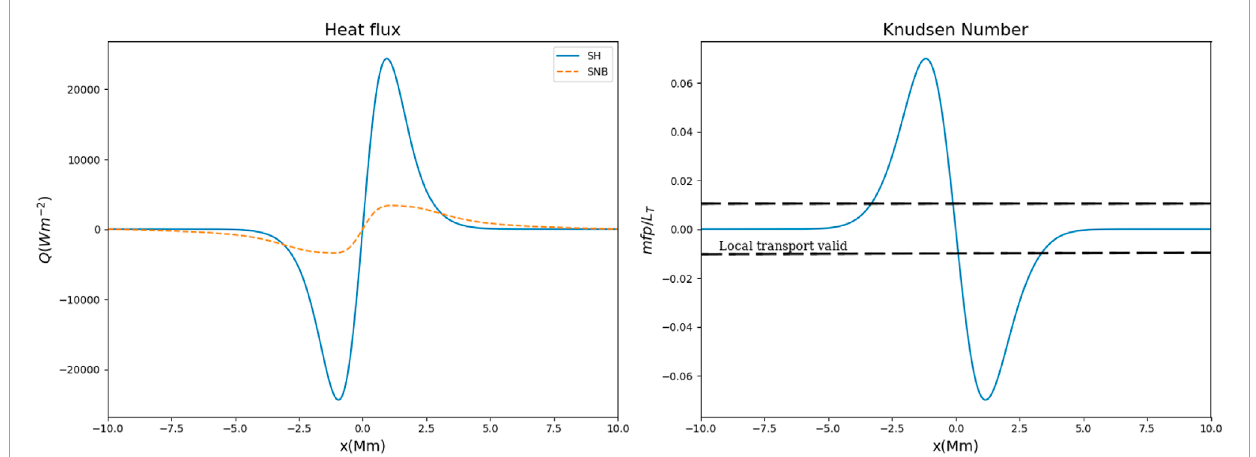
FIGURE 1 Left: Heat flux from the Spitzer–Harm model and the SNB flux for the same temperature profile. Right: The Knudsen number for this temperature profile. The dashed lines indicate the band where the magnitude of the Knudsen number is < 0 . 01. A local model for heat flow is not valid outside of this